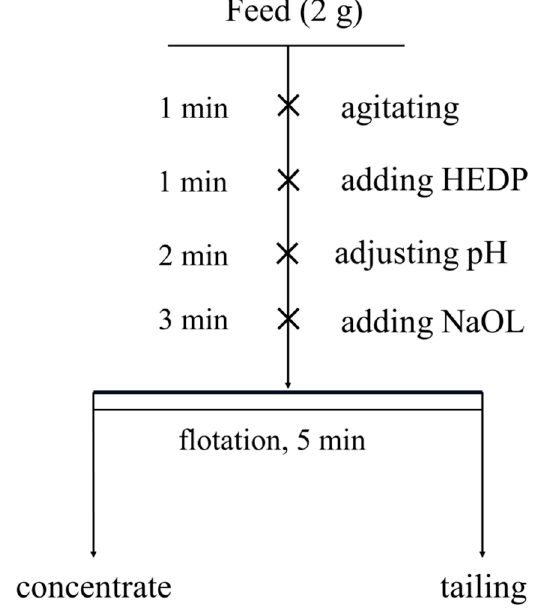
Figure 2. Flow sheet of single-mineral flotation experiment.